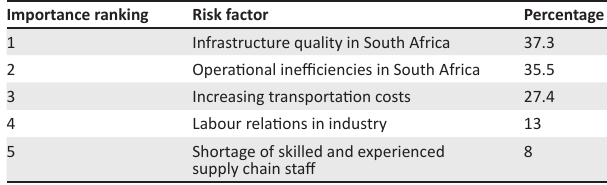
TABLE 2: Ranking of most important supply chain risks or